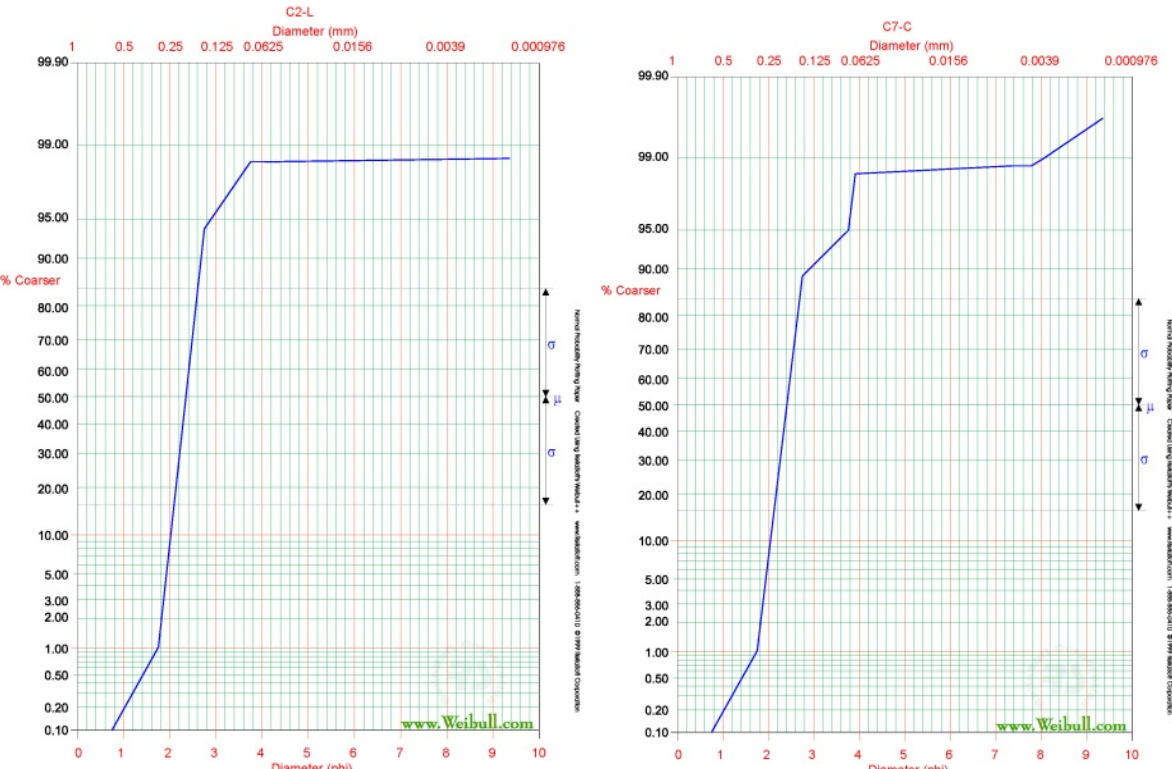
Figure 9: Cumulative curves of the bed sediment of Tigris River at Baghdad for the sampling points CS2-L and CS7-C